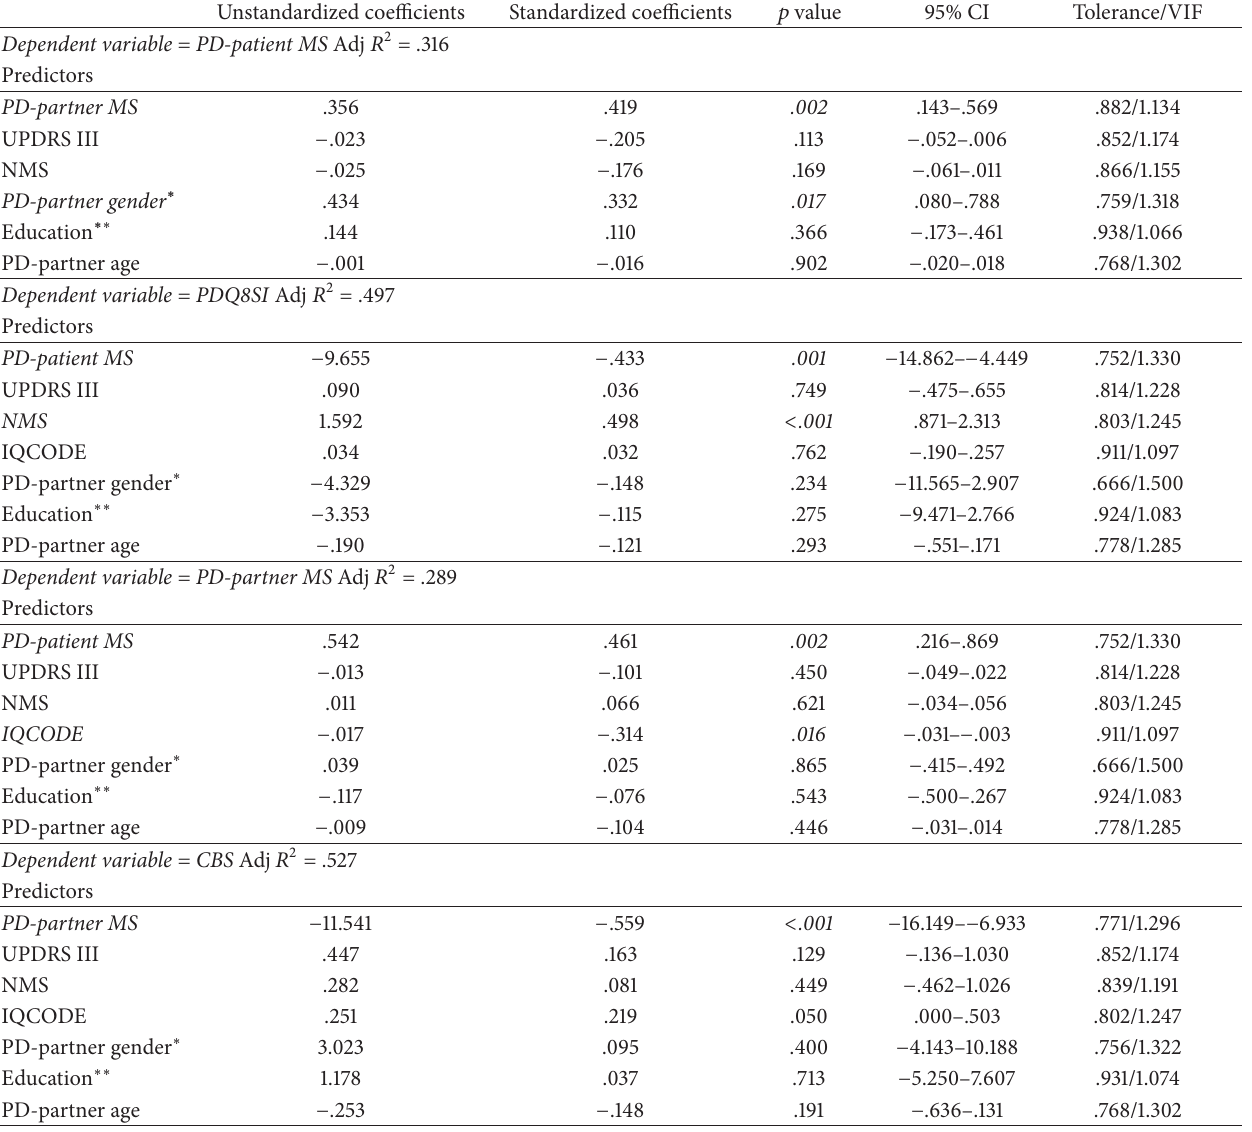
Table 5: Multiple linear regression analysis to find predictors of the Parkinson’s Disease Summary Index (PDQ8SI), caregiver burden scale, PD-patient mutuality, and PD-partner mutuality. 𝑛 = 51